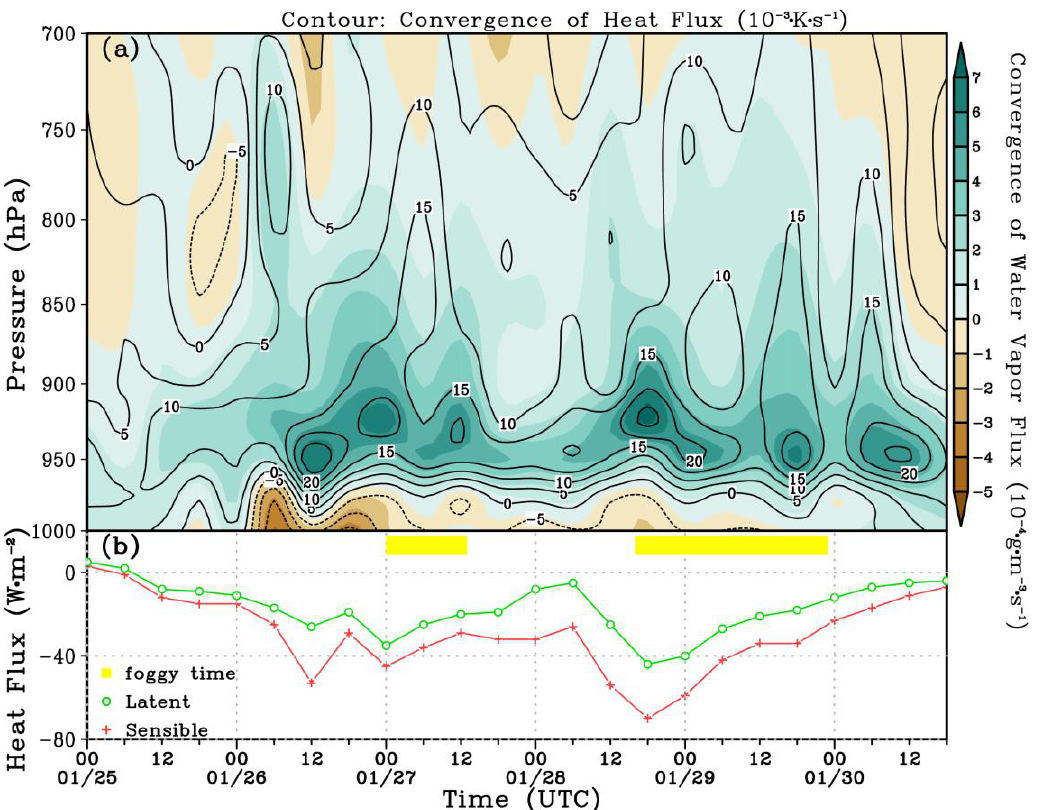
Figure 8. Time series of convergence of water vapor flux ( a ; color shading, unit: 10 − 4 g · m − 3 · s − 1 ) and the convergence of heat flux (contour, unit: 10 −3 K·s −1 ) at different levels, and the surface latent ( b ; green) and sensible heat flux ( b ; red) near King George Island. The yellow color represents foggy time.